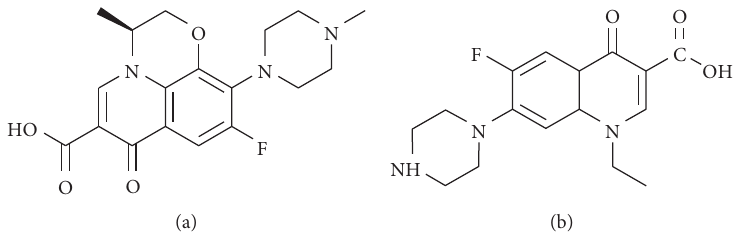
Figure 1: Molecular structure of (a) LVF and (b)